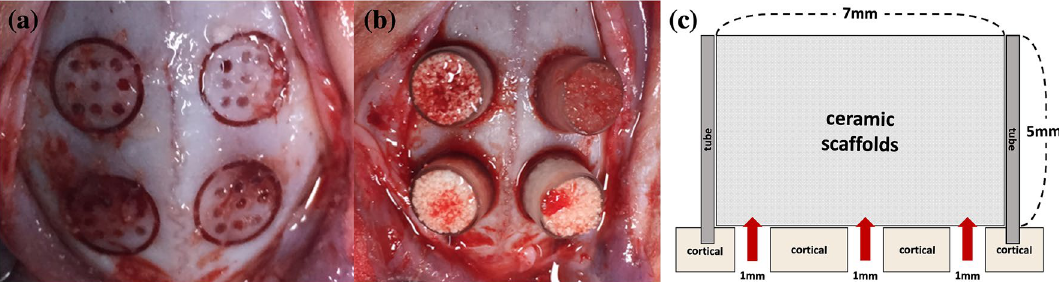
Figure 4. Subperiosteal dissection of the calvarium of New Zealand white rabbits. (a) Four borders on each calvarial bone. Each 7 mm diameter circular border contained nine holes of 1 mm diameter; (b) Insertion of scaffold into customized polycarbonate tubes (Φ 7 × 5 mm) (c) Diagram of experimental